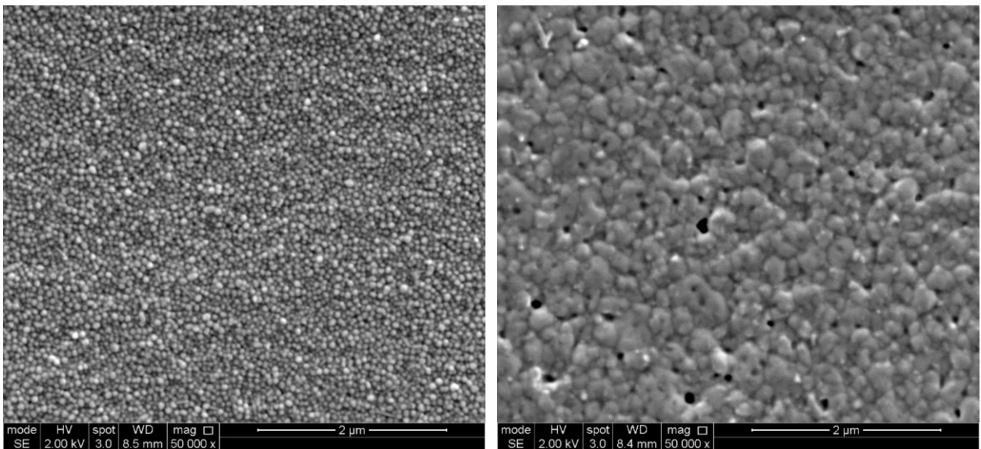
Figure 6. SEM of an inkjet-printed silver nanoparticle ink. The micrograph to the left represents the ink as printed, and the one to the right represents the ink after thermal sintering at 200 ◦ C for 60